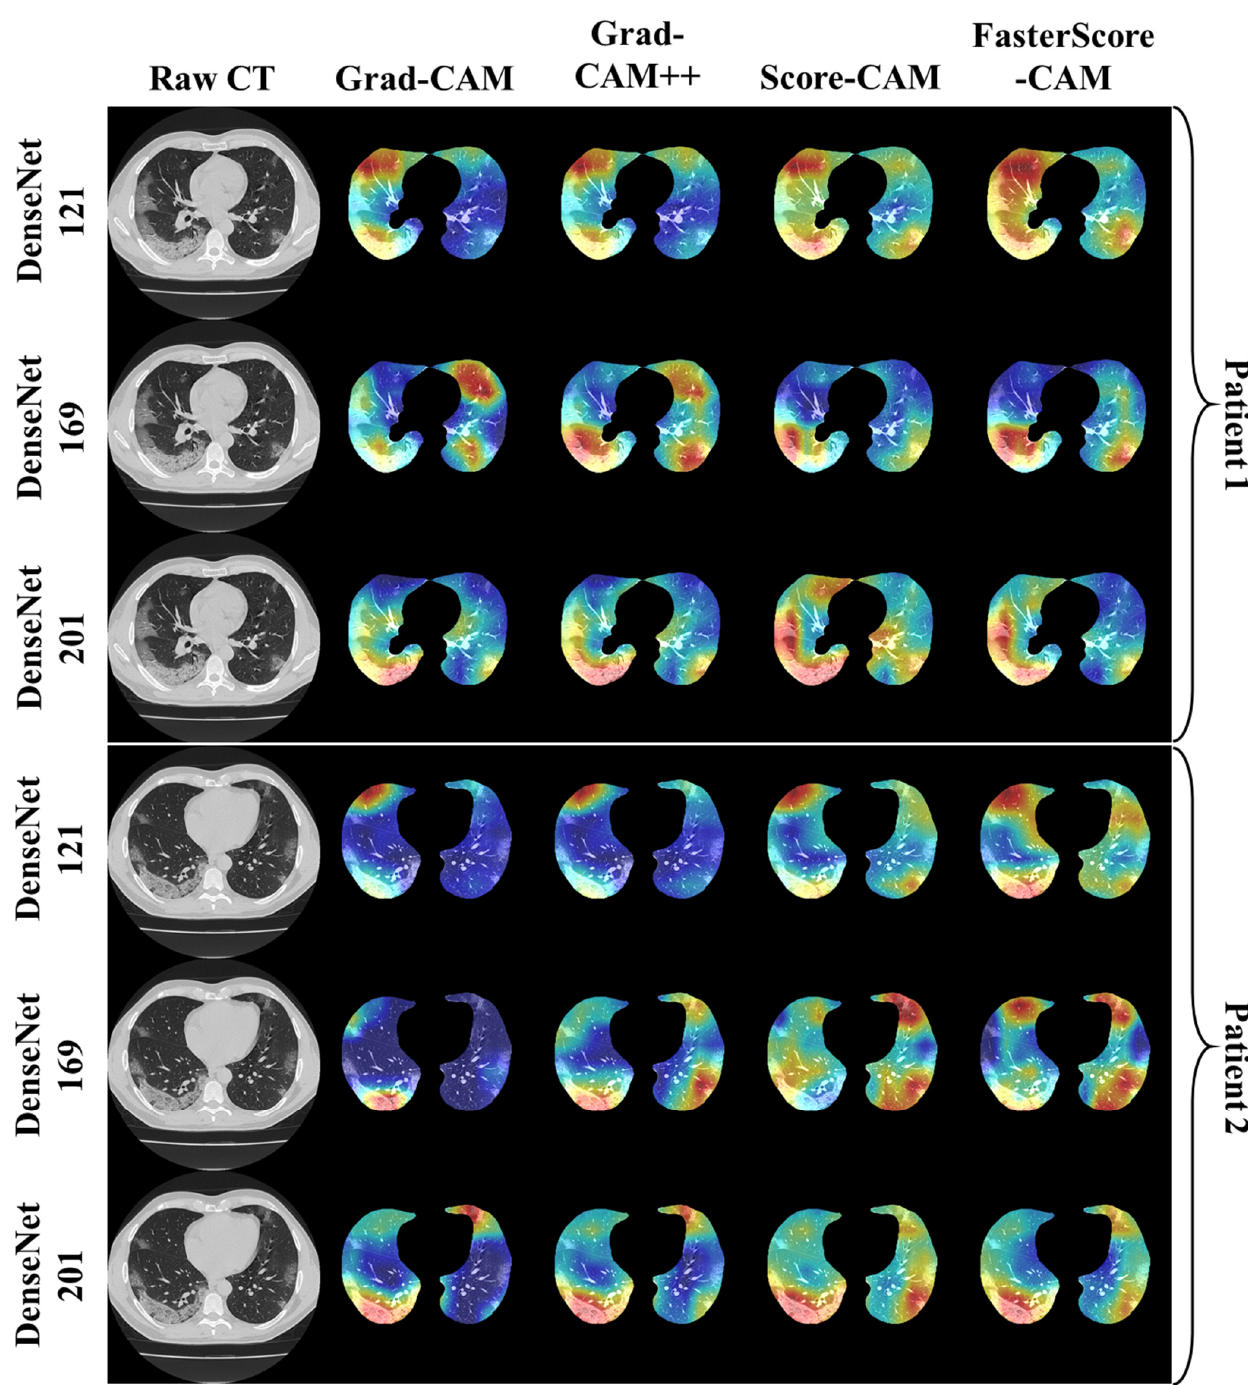
Figure 9. Heatmap using four CAM techniques and three kinds of DenseNet classifiers on COVID-19 lesion images. The top row is the CT slice for patient 1, and the bottom row is the CT slice for patient 2.